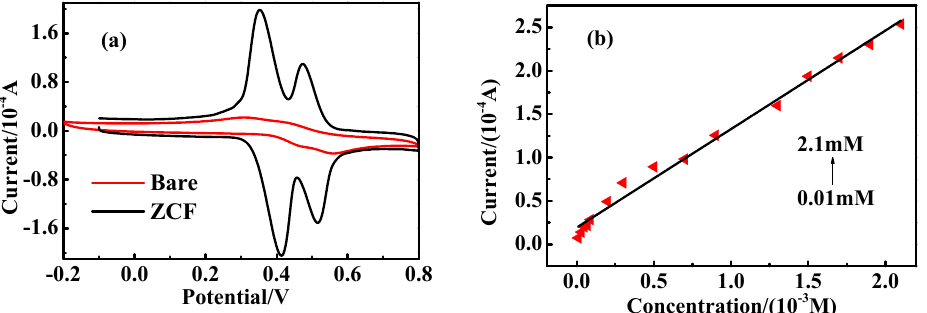
Figure 9. The electrocatalytic behavior of ZCF/GCE in the mixture solution of HQ and CC ( a ) the current in the mixture solution of HQ and CC; ( b ) the relation curve of oxidation peak current and CC concentration.